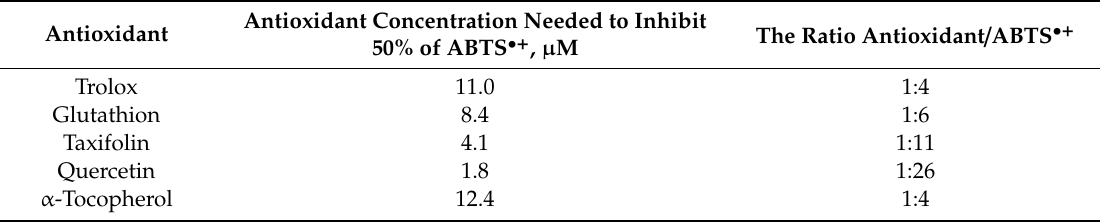
Table 4. Reagent concentrations in an ABTS / PP decolorization assay 1